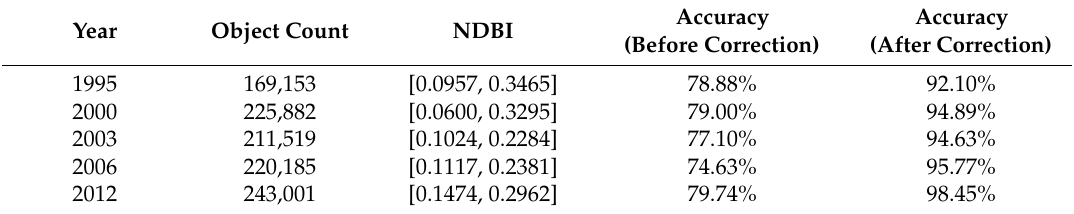
Table 2. Values of NDBI for the extraction of urbanized areas and associated